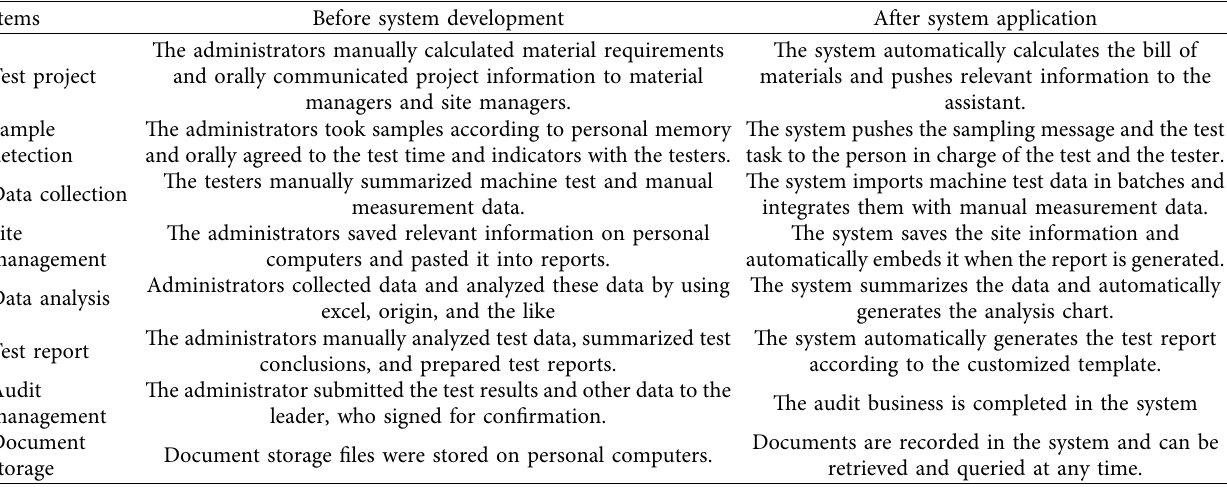
Table 1: Comparison of system application